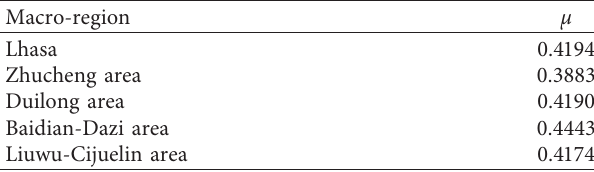
Table 4: Comprehensive deprivation of residents in